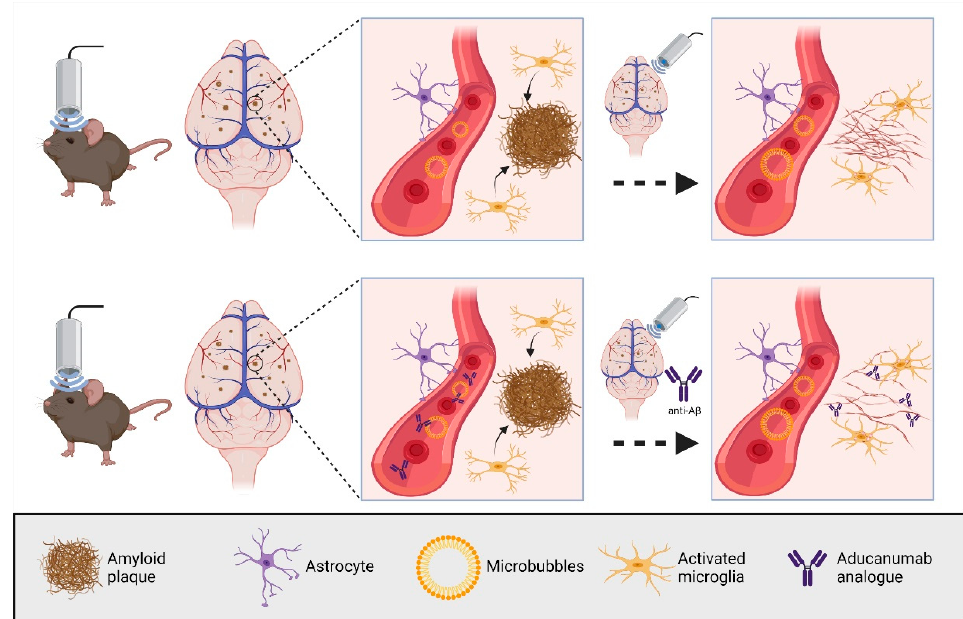
Figure 2. Impact of therapeutic ultrasound application on amyloid pathology. SUS +MB facilitates the uptake of blood-borne factors, which activate microglia. These take up the amyloid into their lysosomes and digest it. Amyloid clearance and cognitive functions are improved when SUS +MB is combined with an analogue of the anti-amyloid- β antibody aducanumab (SUS +MB+ aducanumab analogue ). Created with BioRender.com.